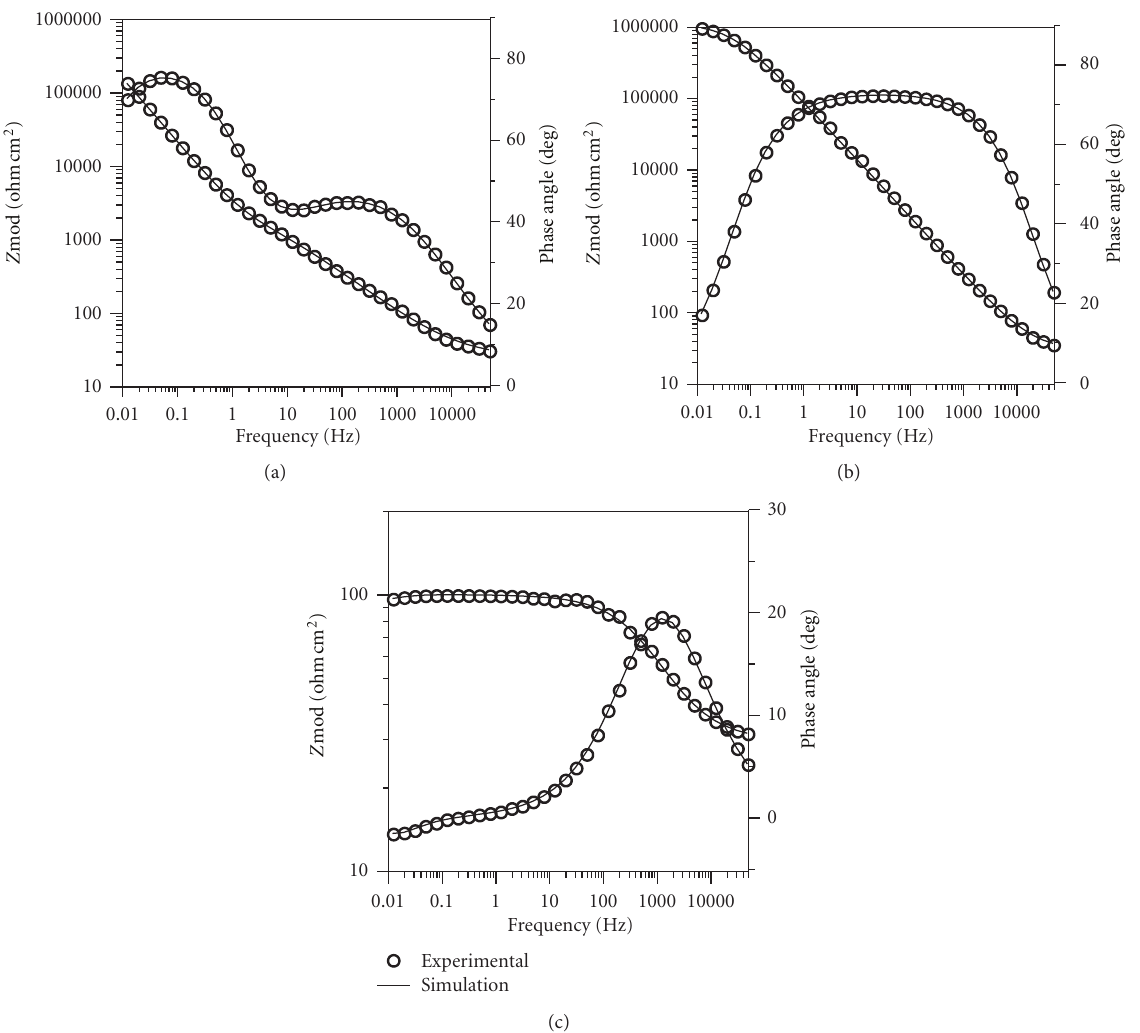
F 4: Bode plots for EIS data of NiTi alloy at (a) open circuit potential, (b) passive region, and (c) dissolution region.